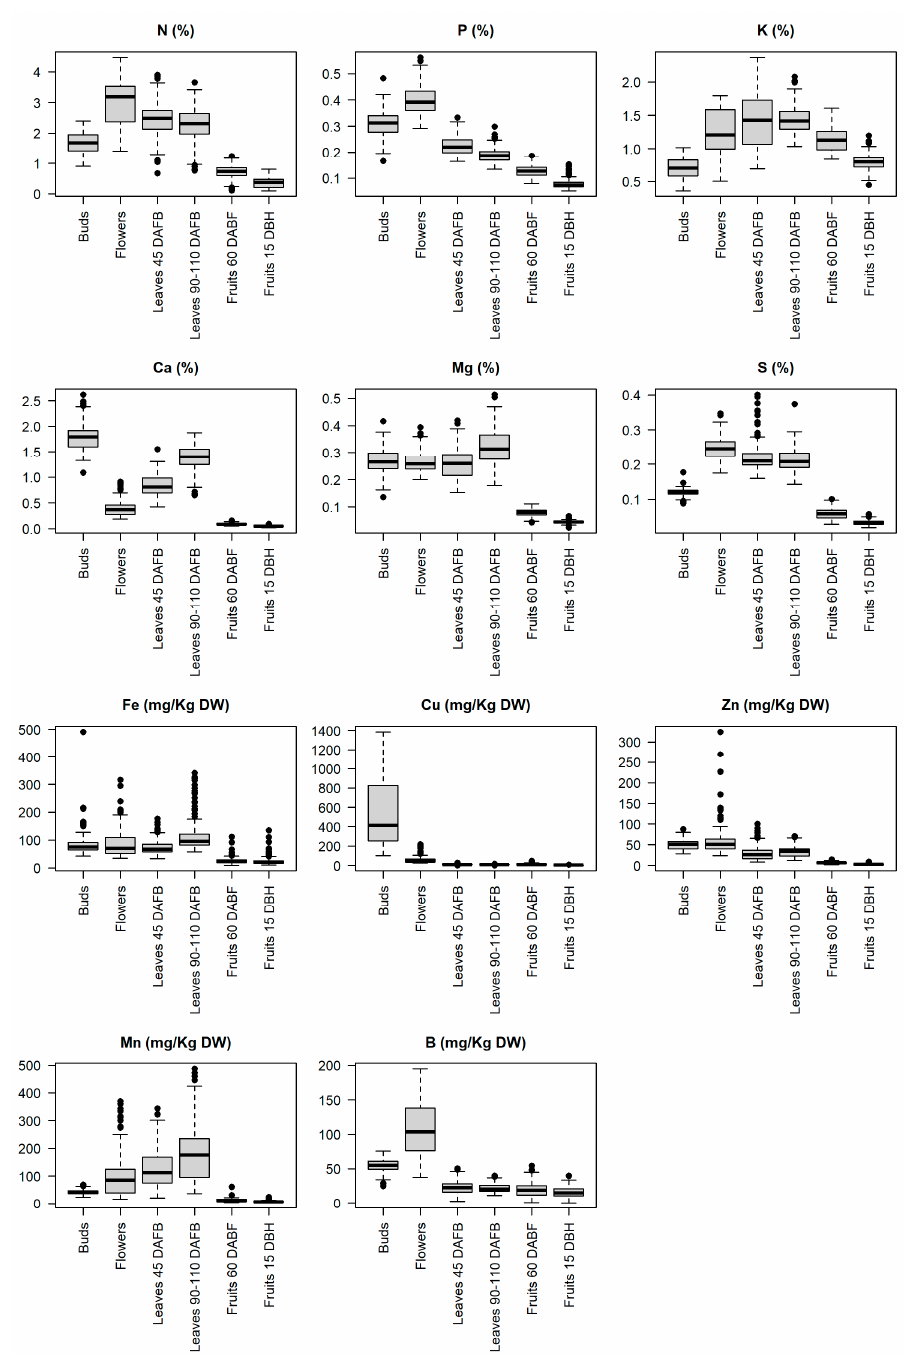
Figure 1. Boxplots with the distribution of each macronutrient content (%) and micronutrient content (mg kg − 1 DW) across the apple organs. Dots represent outliers defined as values outside the whiskers Q1 − 1.5 (Q3–Q1) and Q3 + 1.5 (Q3–Q1) where Q1 and Q3 are the first and third